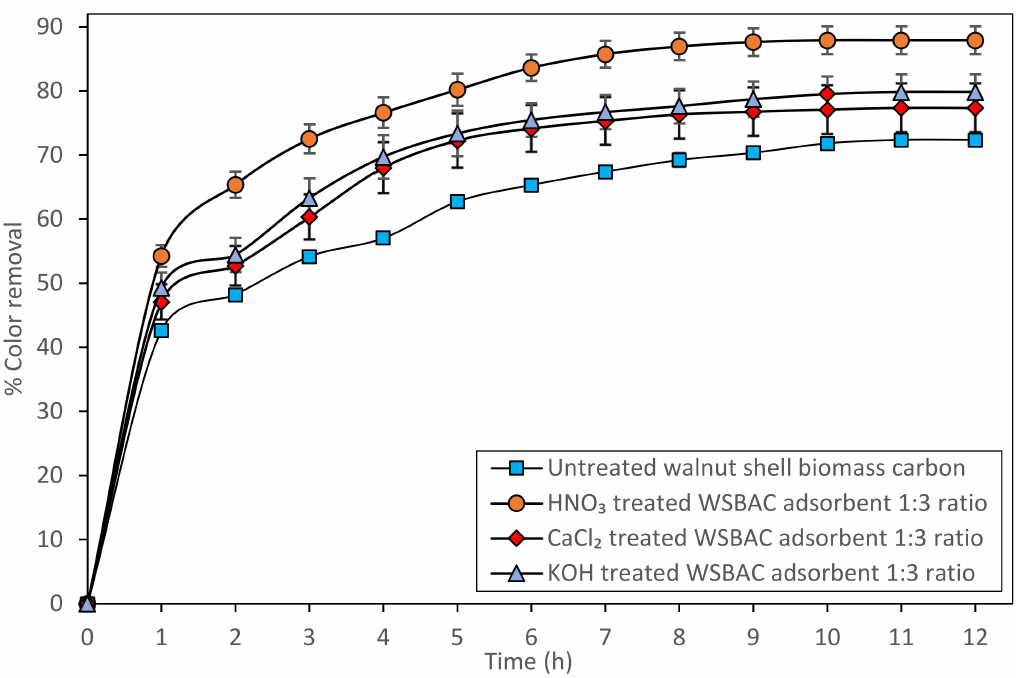
Figure 1. Selection of suitable reagent for activation of walnut shell biomass carbon for the decoloriza- tion of Remazol Brilliant Blue-R (RBBR) dye. (Initial pH: 2; Initial dye concentration: 200 mg L − 1 ; walnut shell biomass activated carbon (WSBAC) adsorbent dosage: 5 g L − 1 ; adsorbent particle size: < 200 µ m; agitation speed: 150 rpm; temperature: 301 K; contact time 12